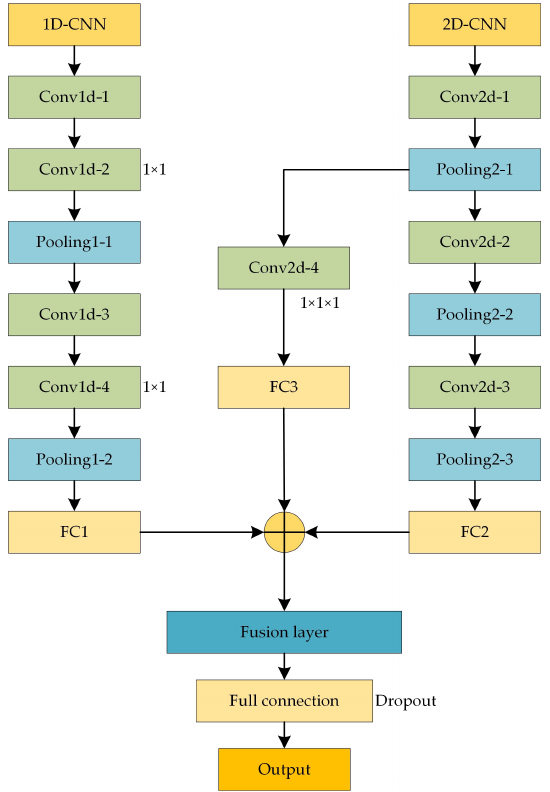
Figure 2. The structure of